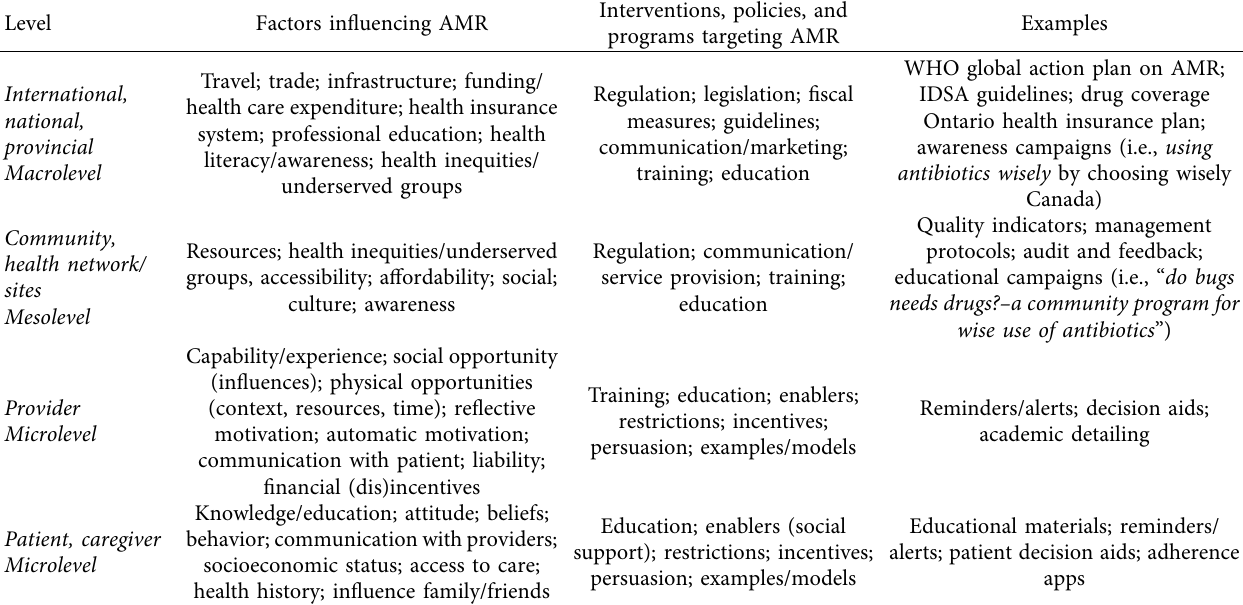
Table 1: Framework stratifying drivers and interventions of AMR and